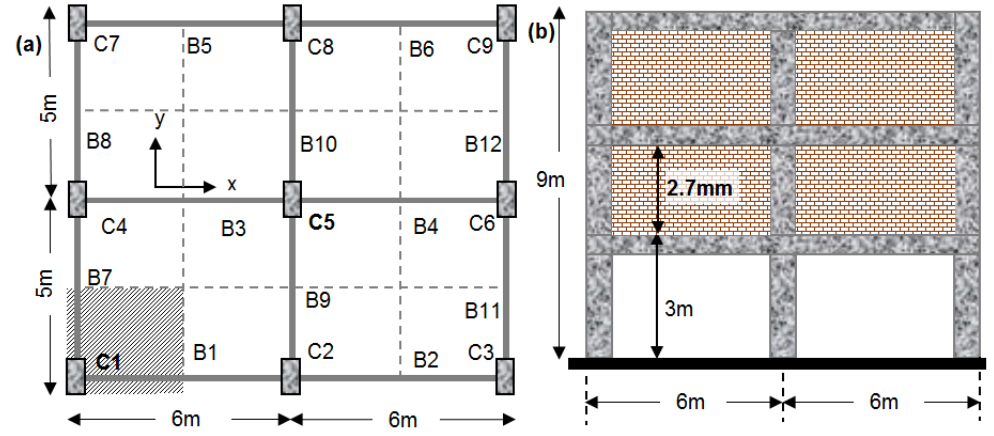
Figure 1. ( a ) Plan view of a typical storey and ( b ) elevation view of the building. Typical columns have a rectangular cross section with h = 350 mm and b = 250 mm, reinforced internally with six longitudinal bars of diameter D b = 14 mm, with clear cover c = 20 mm and effective depth d about the strong axis x being d = 350 − 20 − 0.5 × 20 = 323 mm. The reinforcing ratio is ρ l = As/bh = 1.06%. The columns’ transverse reinforcement comprises stirrups of D b,st = 6 mm at 150 mm centres, all anchored with 90 ◦ hooks at the ends (Figure 2a); this shear reinforcement is of poor effectiveness both due to its magnitude and anchorage detailing. The lap splicing length is developed at the bottom of the column and consists of a straight part l o = 50 D b = 700 mm with end hook (Figure 2a). In this case, the effective splice length is artificially increased by 12.5 D b aiming to account for the influence of the hook (thus l o = 62.5 D b = 875 mm). All beams have a cross section height of h = 400 mm (including the flange thickness that is equal to the slab thickness, h slab = 200 mm) and breadth b = 200 mm, reinforced as presented in Figure 2b. The beam transverse reinforcement comprises stirrups of D b,st = 6 mm at 250 mm centres anchored with 90 ◦ hooks at the ends. The materials mean strength is considered for the assessment procedure [28]: the mean in situ cylindrical concrete compressive strength is f cm = 16 MPa (by following [29]). The longitudinal reinforcement is ribbed steel StIV with an average yield strength based on tests of extracted samples f ys = 500 MPa. Transverse reinforcement is smooth steel StI with an average yield strength based on tests of extracted samples f yw = 240